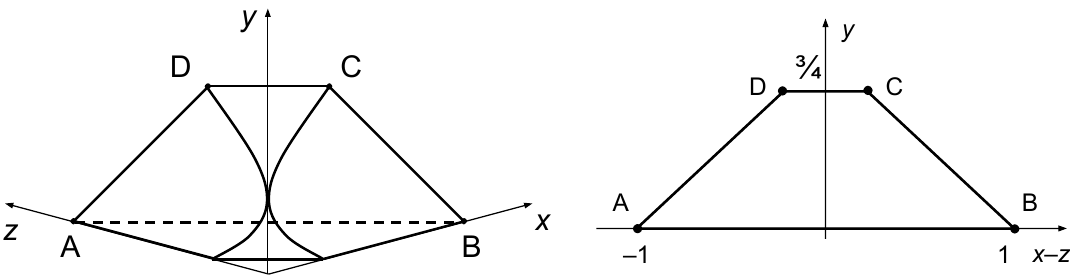
Figure 3 . Left: a sketch of the orbit space of the S 4 -symmetric 3HDM in the ( x, y, z ) -space. Right: the neutral orbit space in the ( x − z, y ) plane. On each plot, the four dots A , B , C , and D mark the positions of the possible neutral global